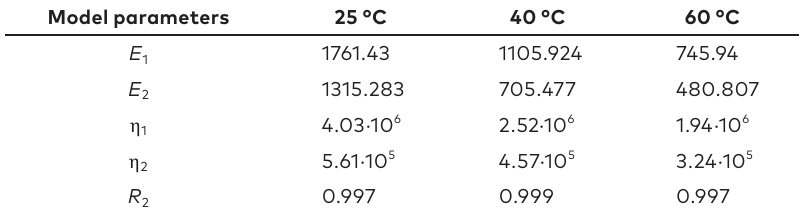
Table 2. The Burger model parameters under three temperatures Model parameters